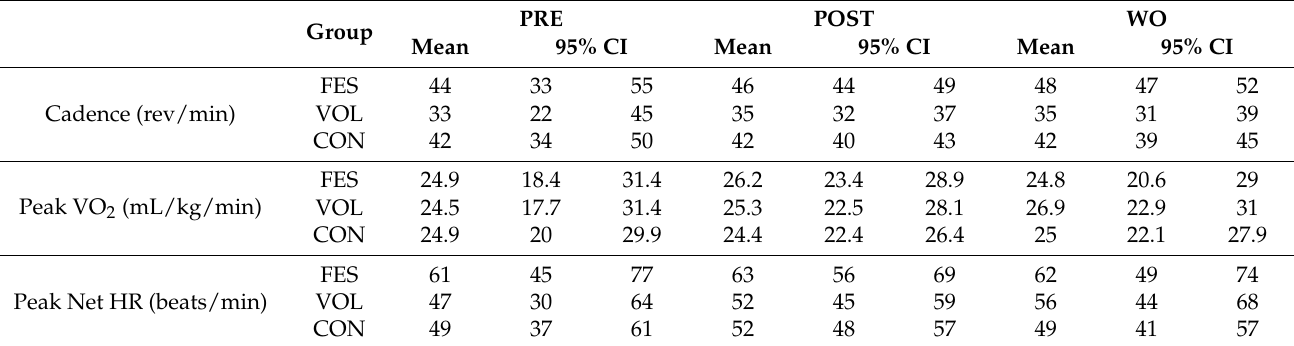
FES, functional electrical stimulation; VOL, volitional; CON, control; WO, washout; VO 2 , ventilated oxygen; HR, heart rate.